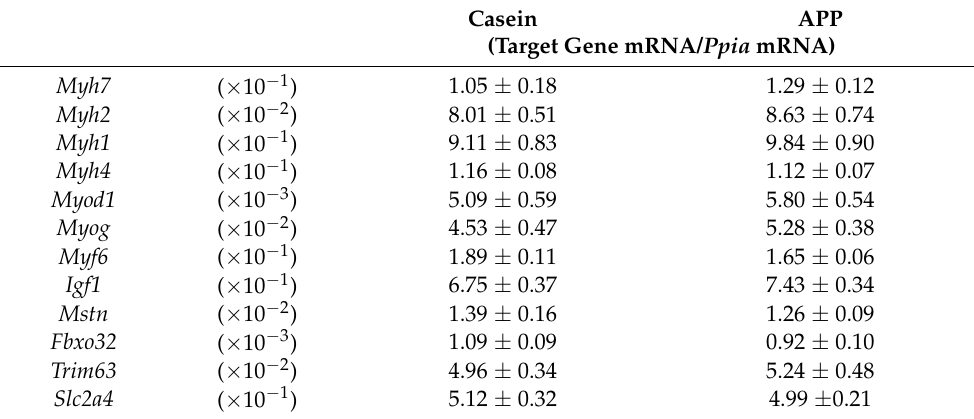
Table 6. Effect of APP for 56 days on gene expressions of myosin heavy chains and regulators of muscle mass and metabolism in the gastrocnemius muscles in rats fed a normal-fat diet.